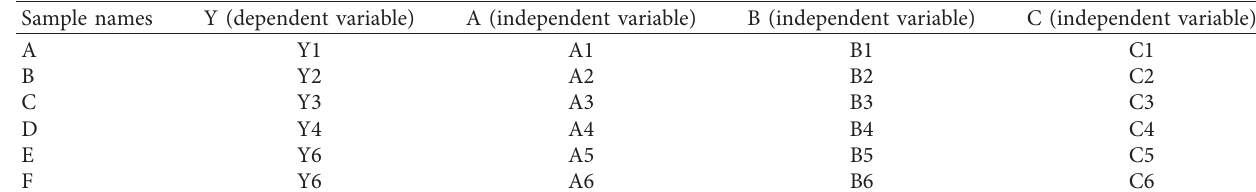
Table 1: Dependent and independent variables.